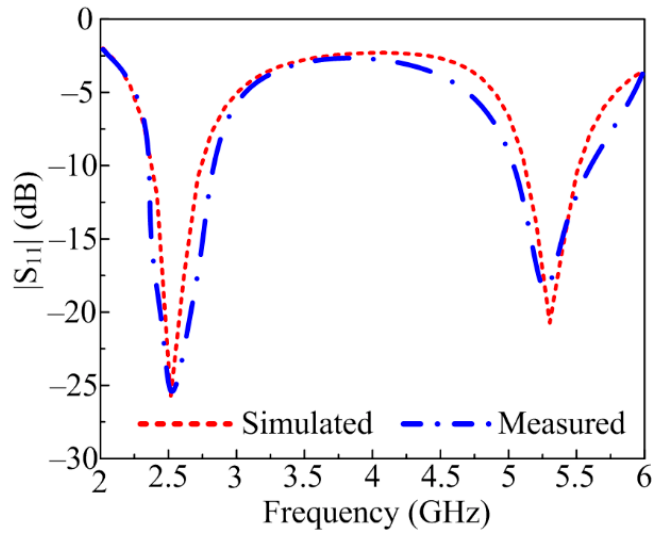
Figure 8. Comparison between simulated and measured S-parameter of proposed work.